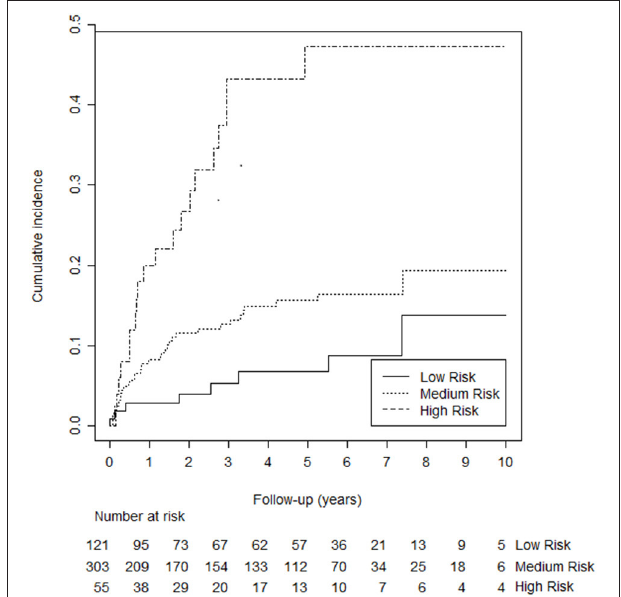
FIGURE 2 | Kaplan-Meier curves illustrating cumulative recurrence according to risk categories of the Continu-8 score. The 5-years probability was 7.7% in